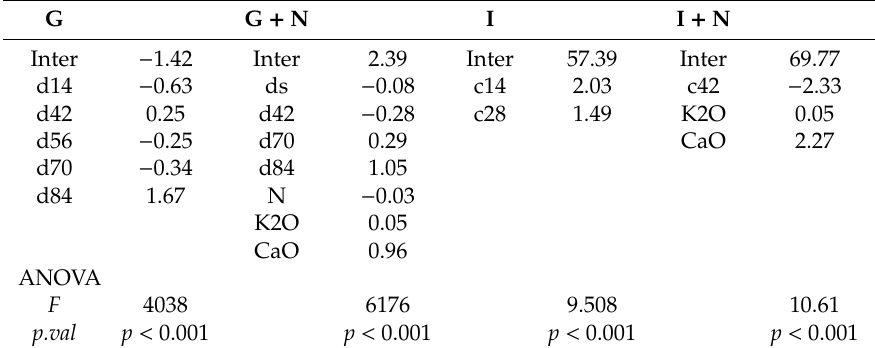
Table 7. Modelling of the Tiben variety final growth (d98) based on development stage and applied nutrients.